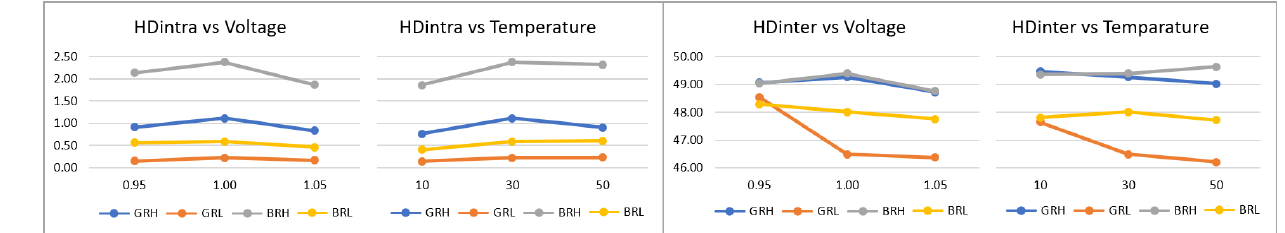
Figure 18. HDintra mean ( left ) and HDinter mean ( right ) versus voltage and temperature variations applying the challenge selection strategy on the test system implemented in the Nexys A7